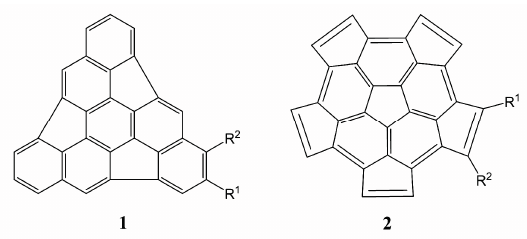
Figure 2. Substituted triindenetriphenylene ( 1 ) and pentacyclopentacorannulene ( 2 ). R 1 and R 2 indicate the substituents. Two cases have been studied: (a) R 1 = R 2 = NH 2 , OMe, OH, Me (methyl), i -Pr (iso-propyl), H, F, COOH, CF 3 , CHO, CN, NO 2 ; (b) R 1 = NH 2 , OMe, OH, Me, i -Pr, H, F, COOH, CF 3 , CHO, CN, NO 2 , R 2 =